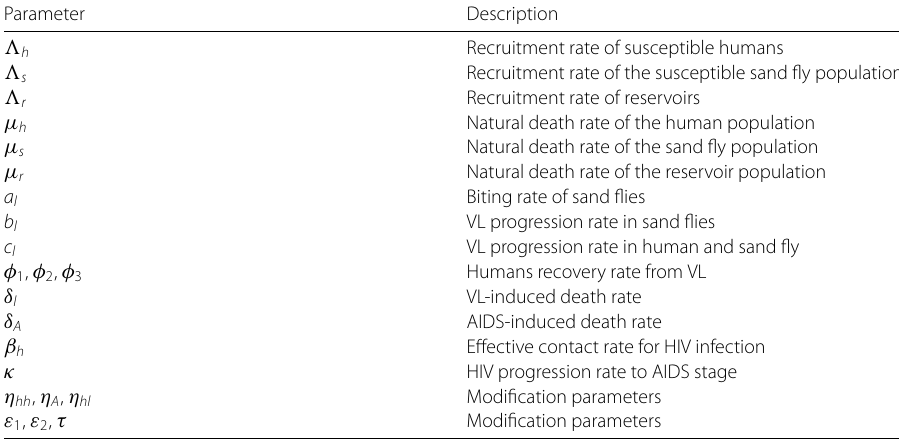
Table 1 Parameter descriptions of the HIV–VL co-infection model Parameter